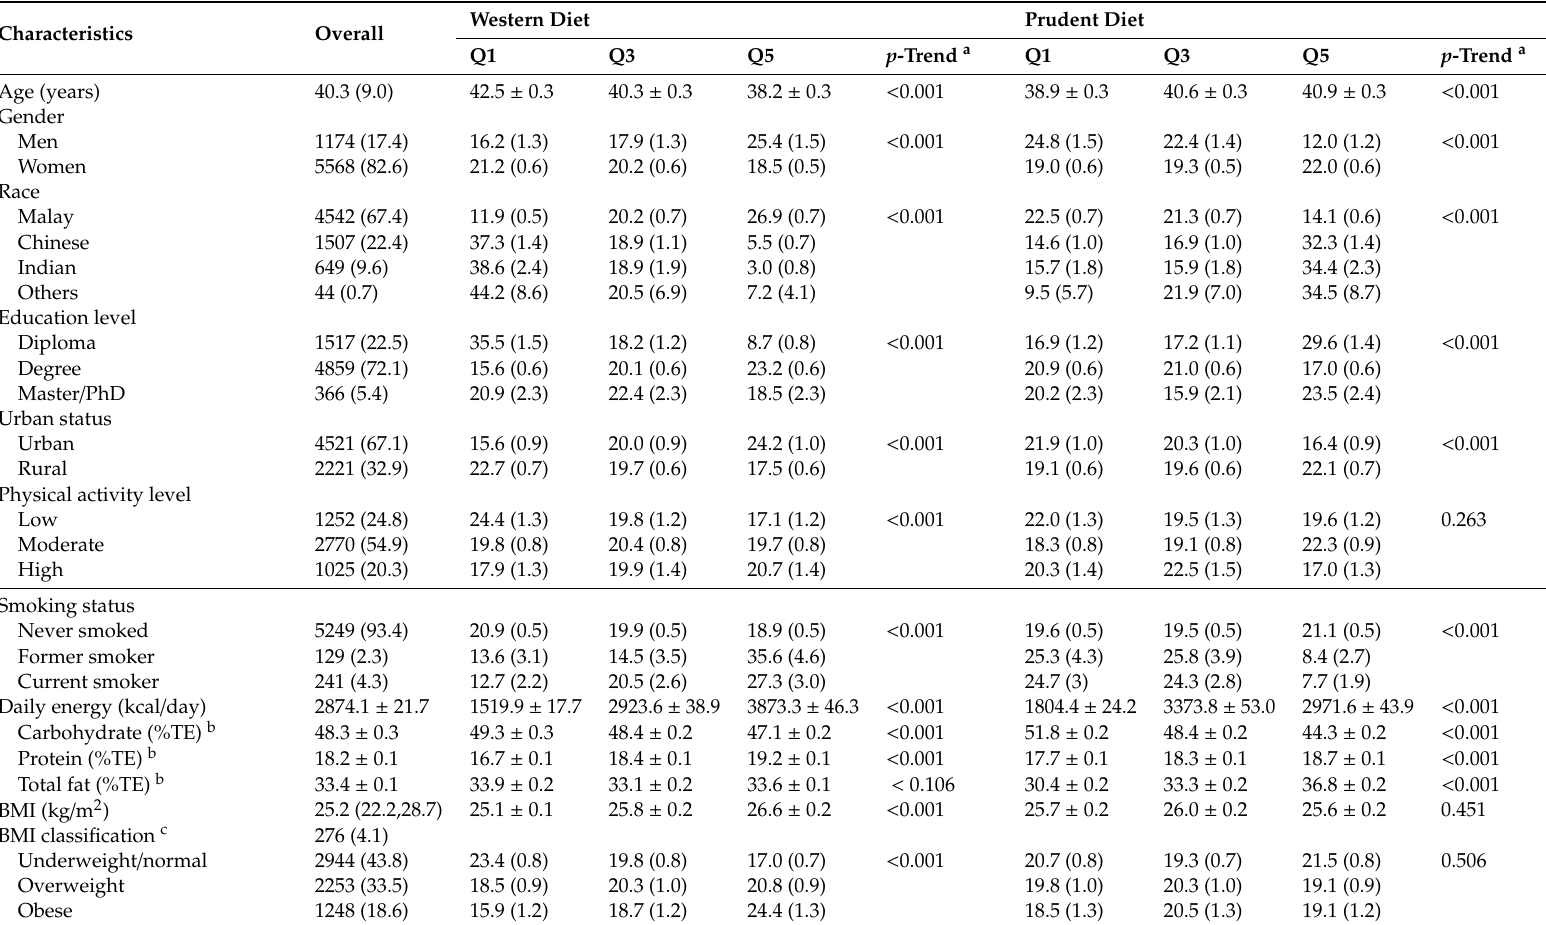
Table 1. General characteristics of the study participants across quintiles of dietary pattern